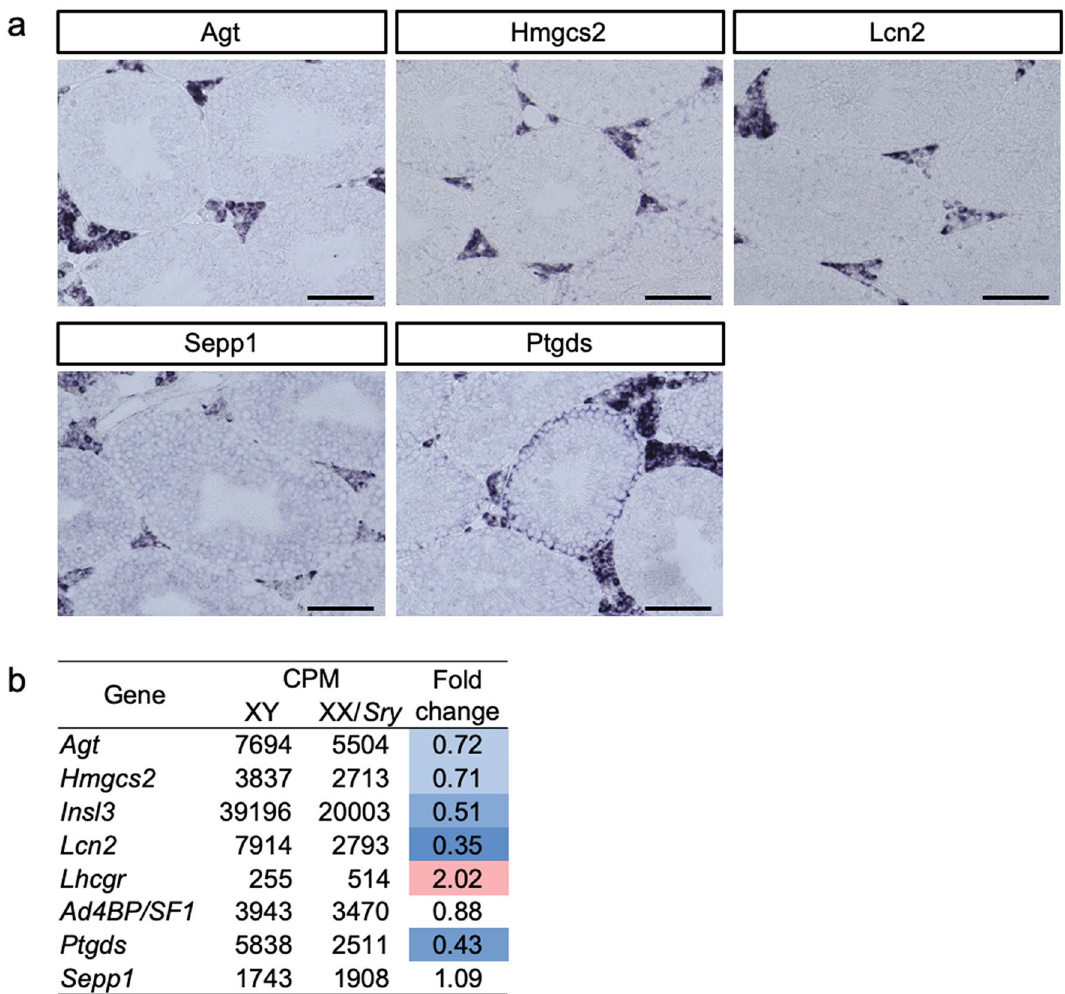
Figure 5. Altered expression of genes normally enriched in ALCs. ( a ) Expression of Agt , Hmgcs2 , Lcn2 , Sepp1 and Ptgds in XY adult testes was examined using in situ hybridization. Scale bars = 100 μm. ( b ) Expression of genes that are normally enriched in ALCs in XY and XX/ Sry ALCs was obtained from the transcriptome datasets. The displayed CPMs are the means of biological triplicates. Increased and decreased gene expression in the XX/ Sry ALCs is indicated in red and blue, respectively, with deeper shading for larger